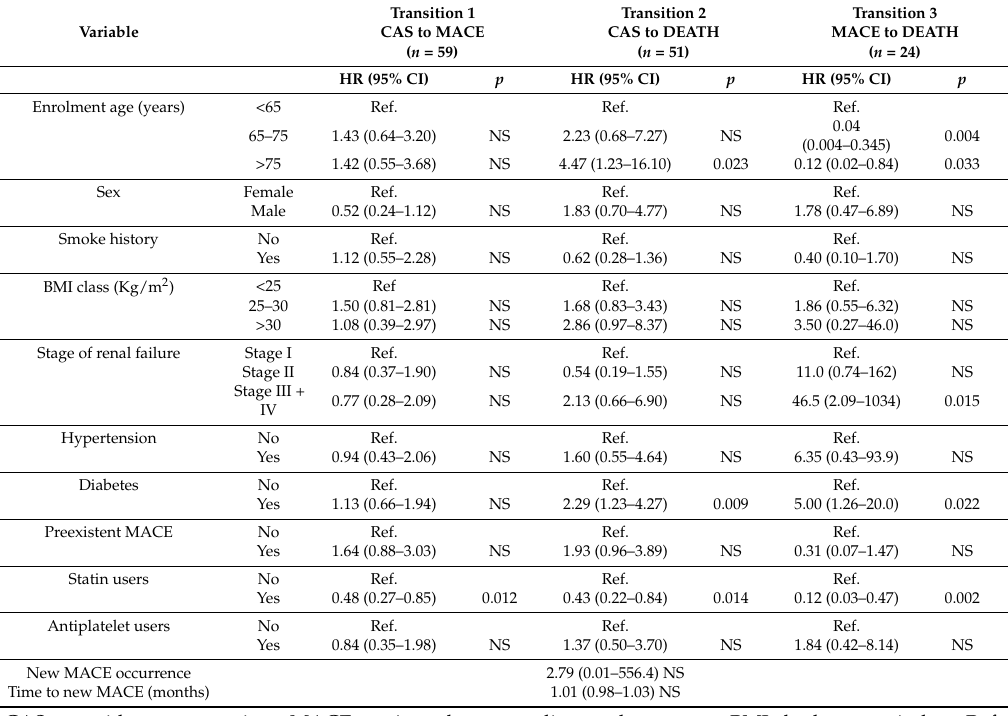
Table 3. Clock-forward multi-state Markov model